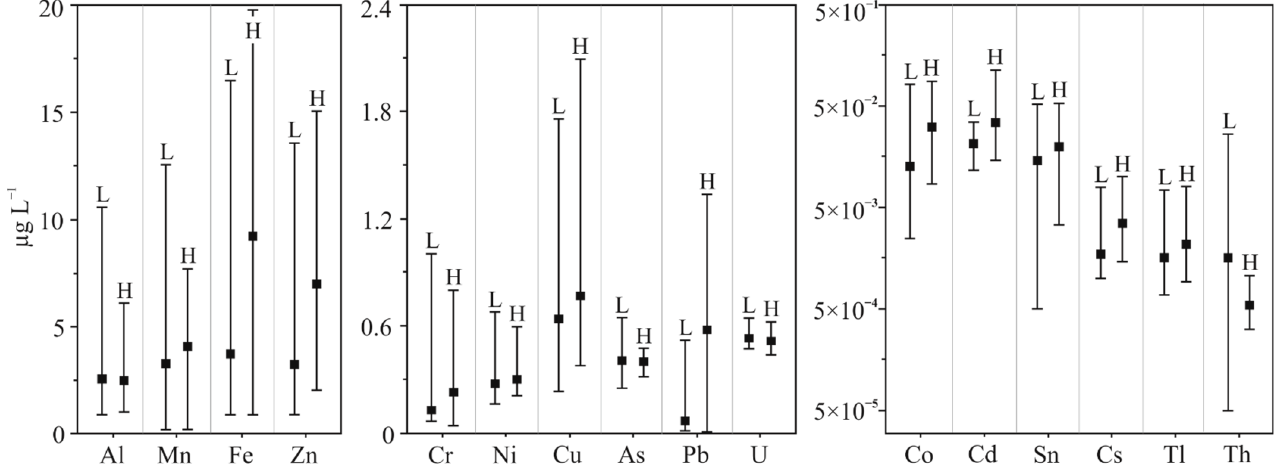
Figure 3. Statistical distribution of trace element concentrations in the water of Angara River source (L, concentrations of trace elements in the lowest water stage; H, concentrations of trace elements in the highest water stage. Black squares represent mean values; whiskers represent maximum and minimum values).